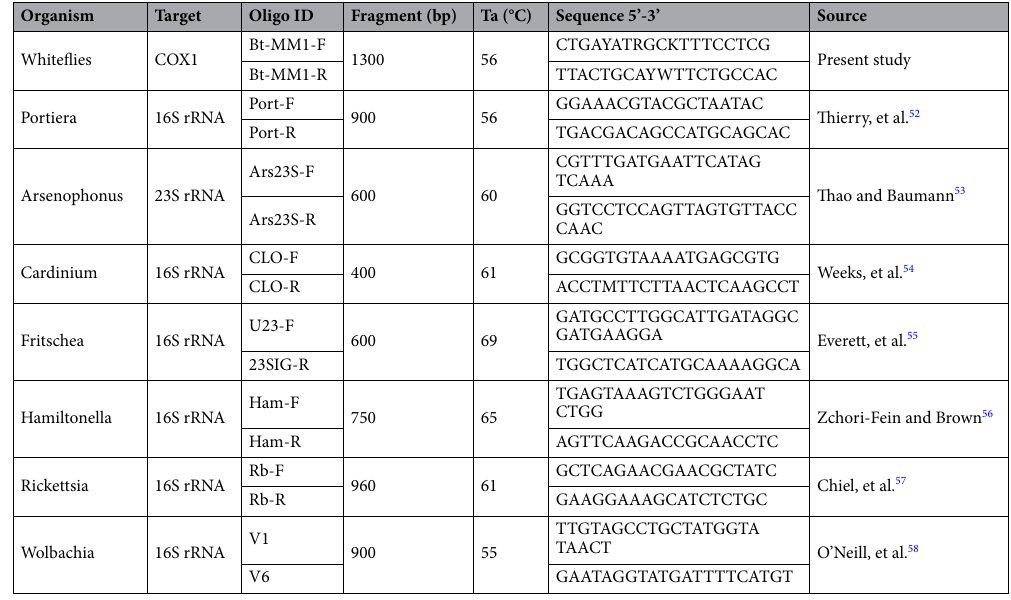
Table 1. PCR primers and corresponding annealing temperatures used for whitefly and endosymbiont detection and